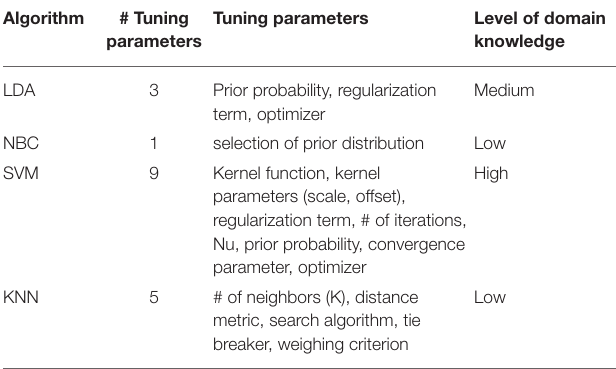
TABLE 3 | Complexity of algorithm implementation. Algorithm